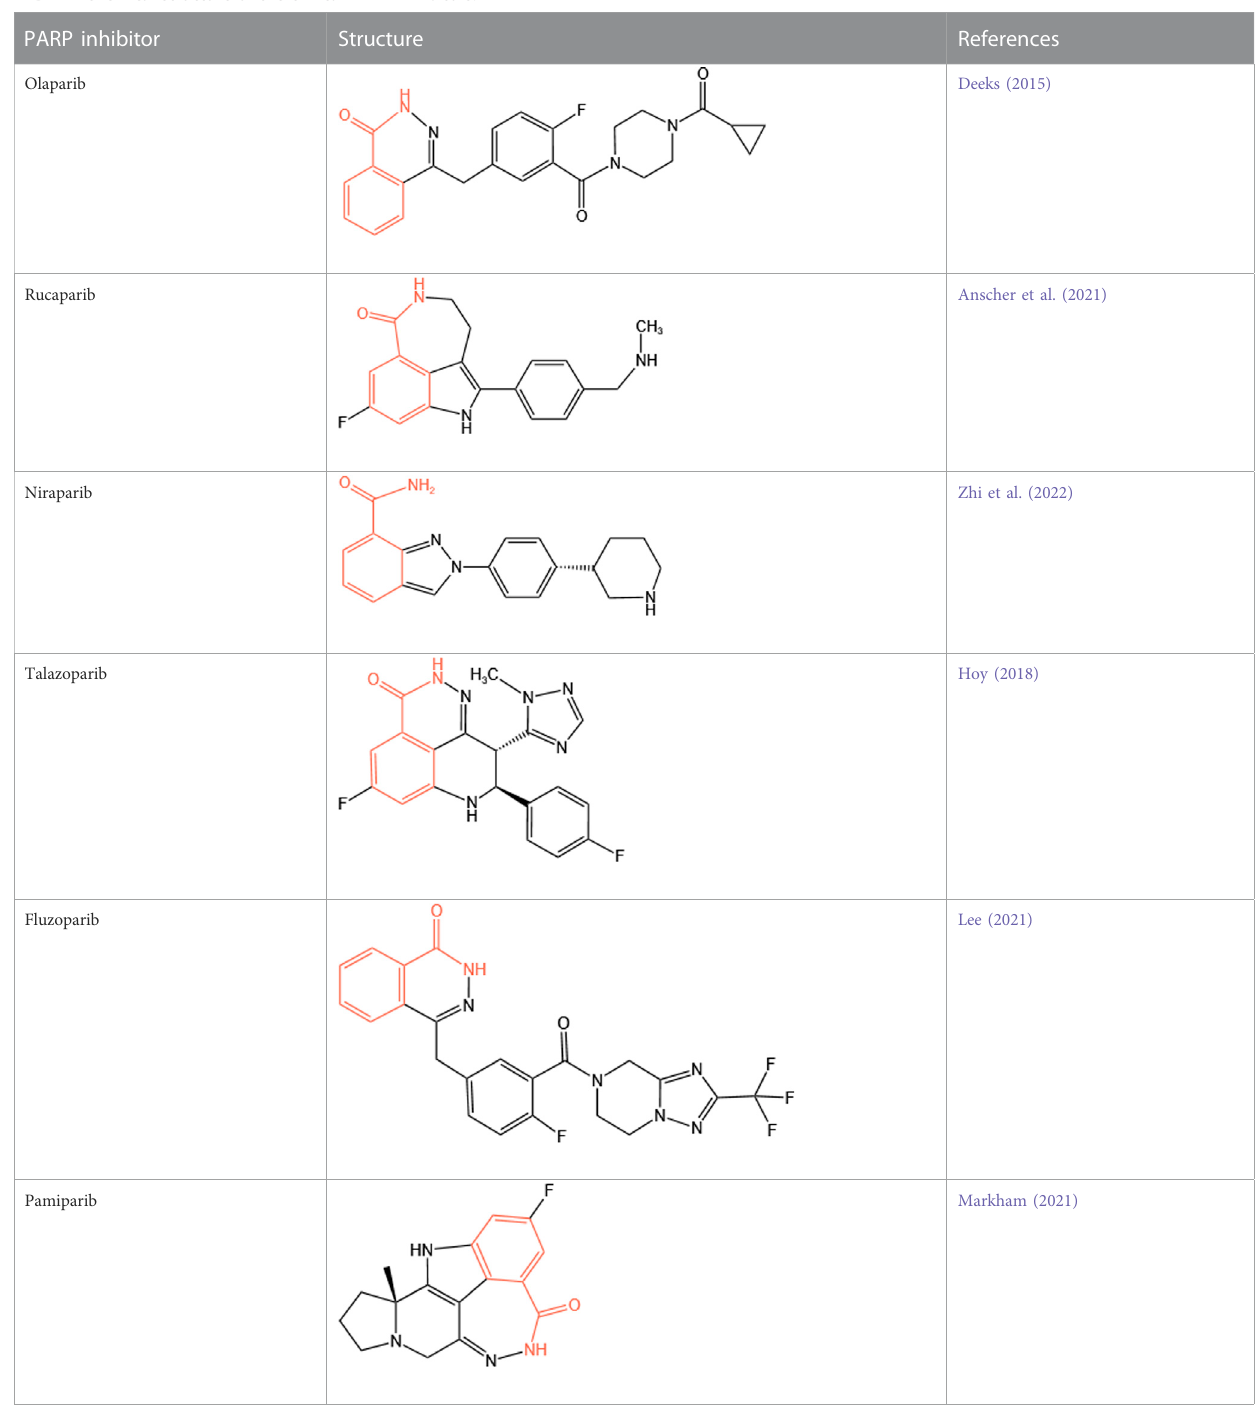
TABLE 1 Chemical structure of the clinical PARP inhibitors. PARP inhibitor